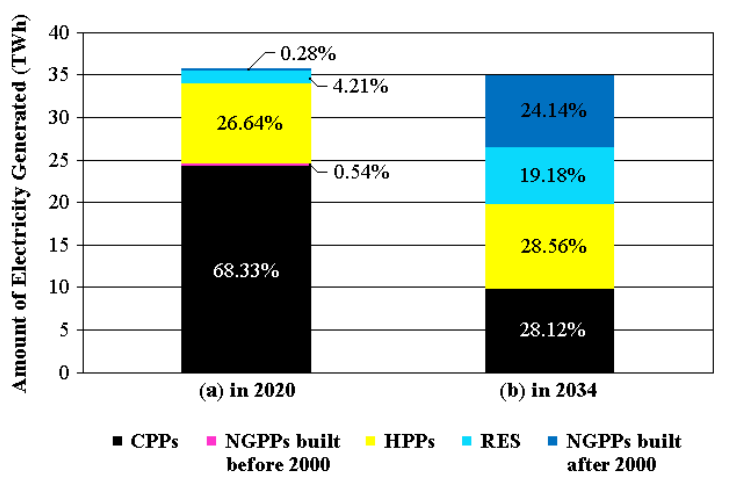
Figure 8. Electricity generation in Serbia: ( a ) in 2020—actual data [55]; and ( b ) in 2034—a projection according to Sub-scenario 2-4.